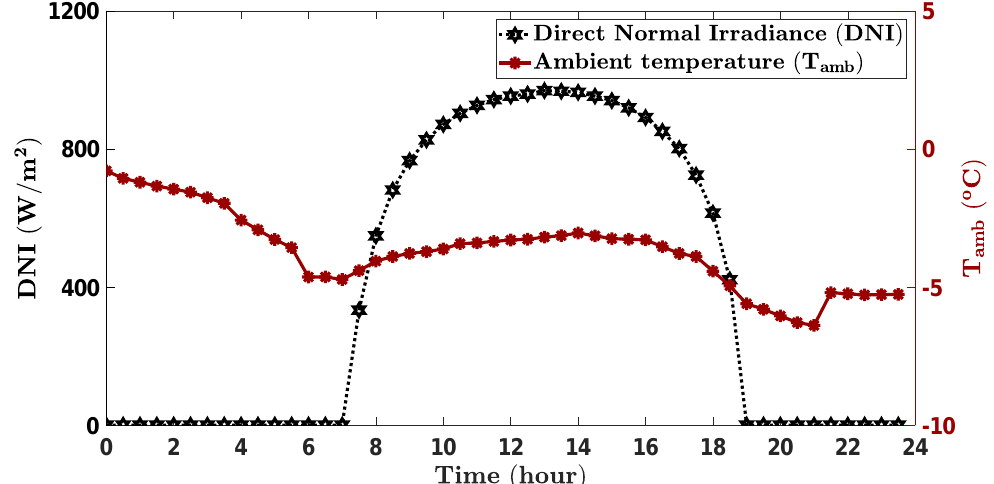
Figure 19. Outdoor ambient temperature ( T amb ) and solar direct normal irradiance ( DNI ) and measured every half an hour for a sample day (18 March 2016) in Houghton, MI, USA. (Reprinted from [21] with permission of